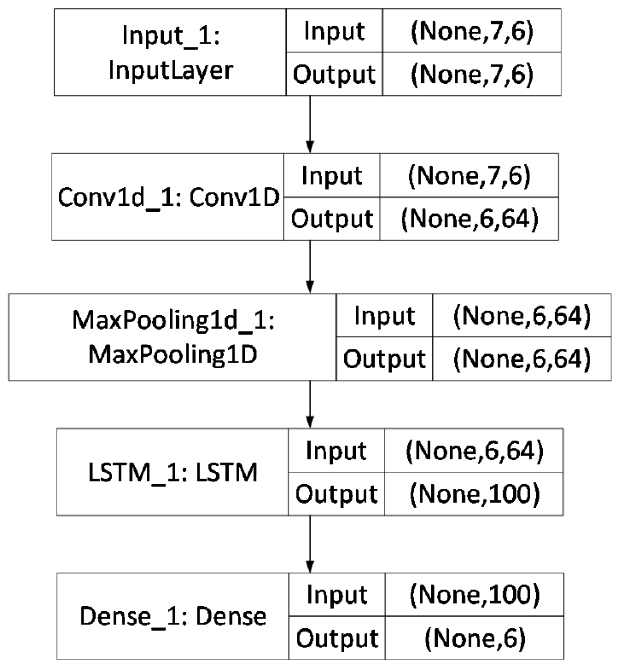
Figure 3. Basic structure of the CNN and LSTM ensemble model for time-series